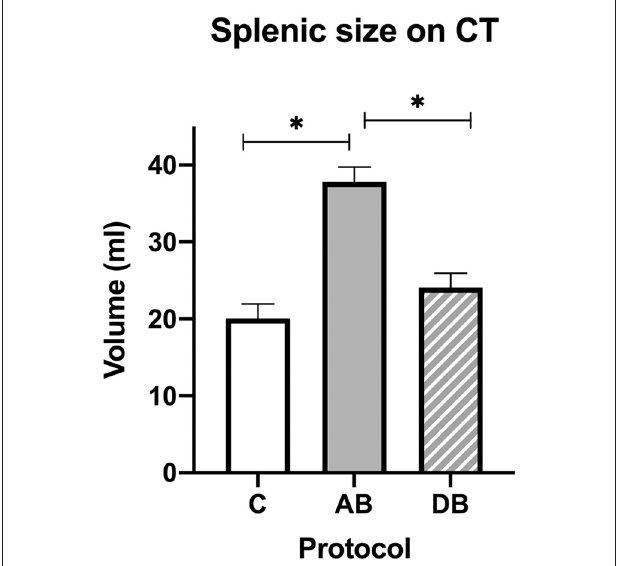
FIGURE 7 | Splenic volumes recorded with CT for the controls and after administration of protocol AB and DB. *Significant differences according to Tukey’s post-hoc tests ( p < 0.05). Bars represent the standard error of the mean